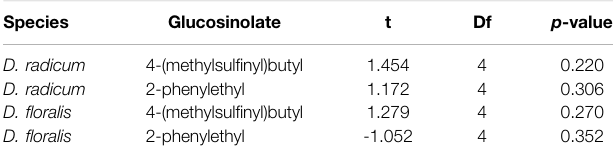
TABLE 1 | Comparison of the glucosinolate content in gut extracts of Delia radicum or D. fl oralis larvae at room temperature or heated for 7 min at 95 ° C and thereafter incubated with 4-(methylsul fi nyl)butyl or 2-phenylethyl glucosinolates. Each condition was represented by three replicates consisting a pool of 10 larval guts each. p -values after t -test comparing GSL content in heated versus normal gut extracts.